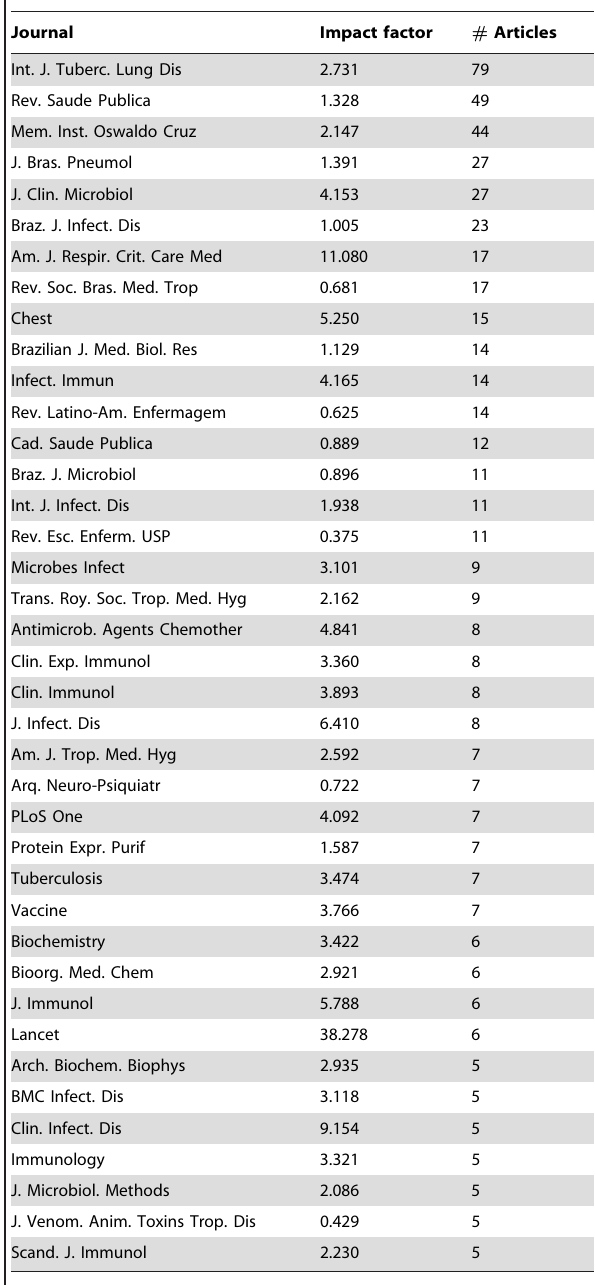
Table 2. Top 25 researchers publishing articles on tuberculosis with Brazilian authors,